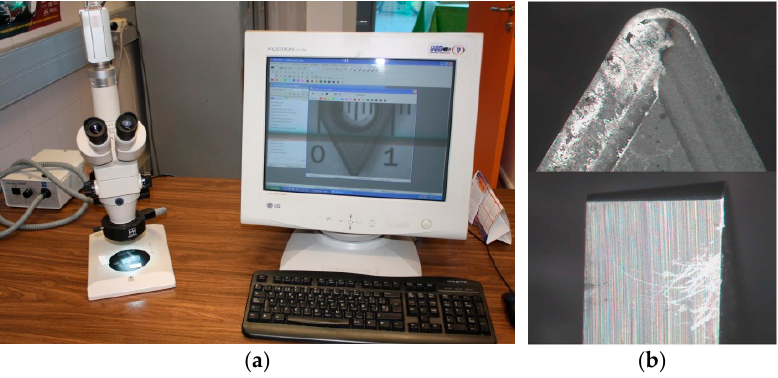
Figure 3. ( a ) SOM equipment setup; ( b ) Rake and flank face SOM images.